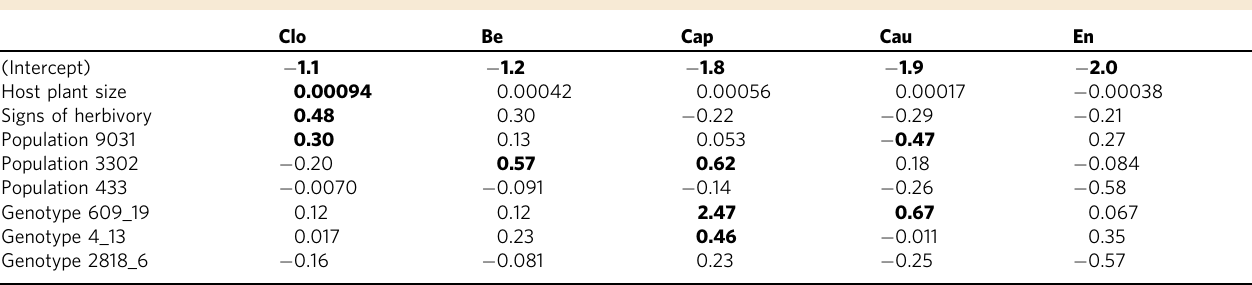
Posterior mean estimates withstatistical support based onthe 90% central credible interval are denoted by bold font. ‘ Clo ’ refers to Plantago closterovirus , ‘ Be ’ to Plantago betapartitivirus , ‘ Cap ’ to Plantago lanceolate latent virus , ‘ Cau ’ to Plantago latent caulimovirus , and ‘ En ’ refers to Plantago enamovirus